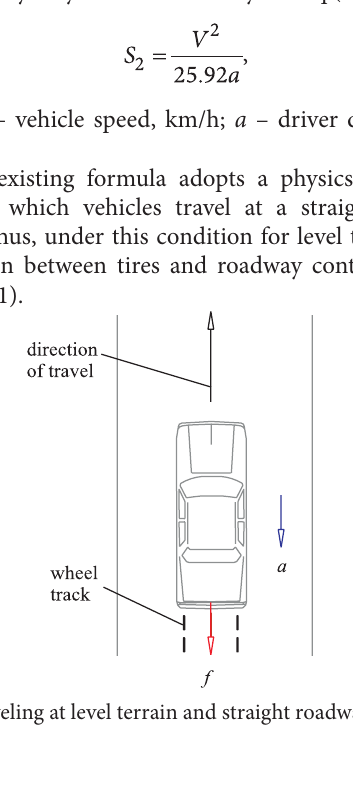
Table 1. Changes in the 6 parameters used for SSD calculation